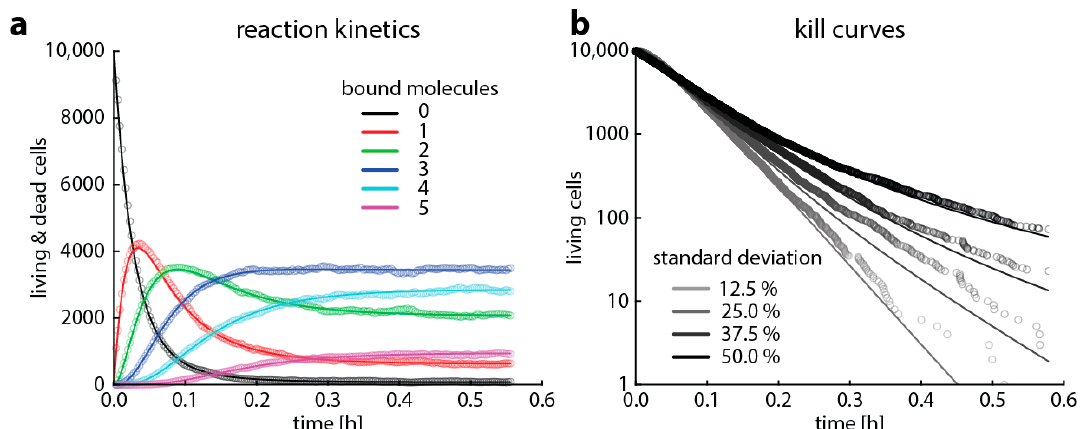
Figure 3. Comparison of the output of a Gillespie algorithm and simulations based on master equations. This is a simplified case for clarity, where a cell only contains five target molecules and dies on average within one second when more than two target molecules are bound. The binding rate k f is 1.2 × 10 6 M -1 s -1 , the unbinding rate k r is 1.2 × 10 -3 (for rifampicin, [25]), and the antibiotic concentration is 1.7 nM (10 15 molecules/liter). ( a ) Shows the predicted average target occupancy: the number of bacteria with 0 (black), 1 (red), 2 (green), 3 (blue), 4 (turquois), and 5 (purple) bound targets for 10,000 Gillespie simulations (dots) or the master equation approach (lines). ( b ) Shows the predicted time–kill curves when modeling 10,000 bacterial cells with Gillespie simulations (dots) or the master equation approach (lines) for bacterial populations where the threshold for killing follows a normal distribution with 12.5%, 25%, 37.5%, or 50% standard deviation.